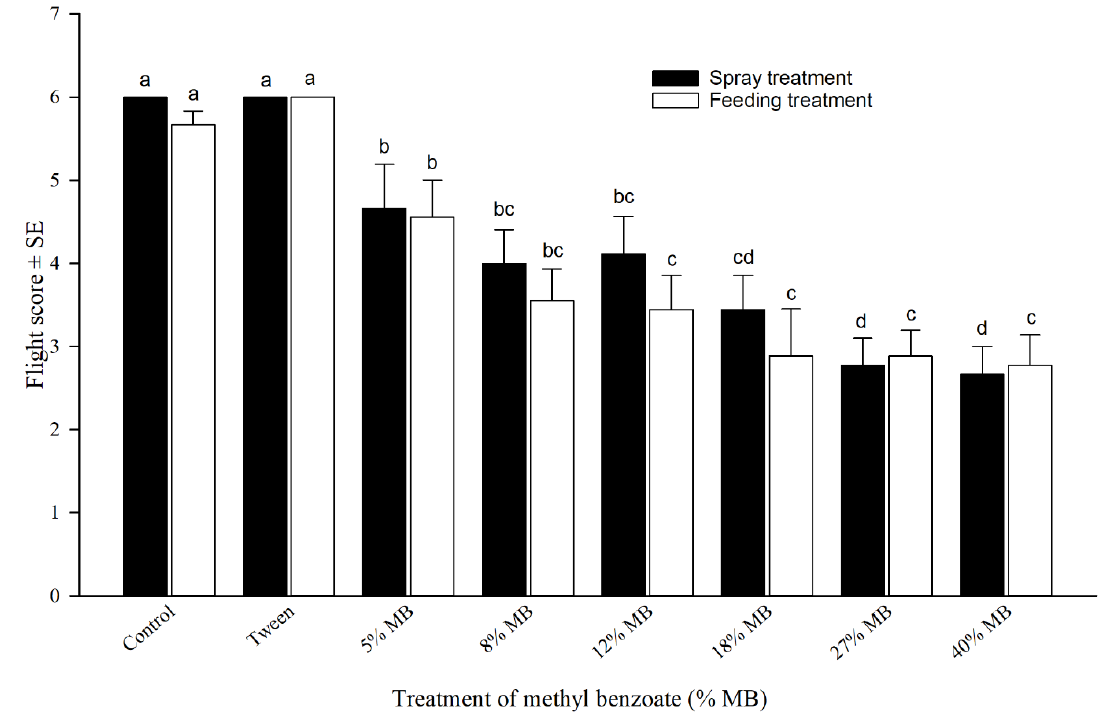
Figure 4. Influence of methyl benzoate (MB) on honey bee flight (performance score for flying 3.66 m). Mean bars with the same letters at the top of error bars indicate no significant difference between treatments ( p > 0.05).